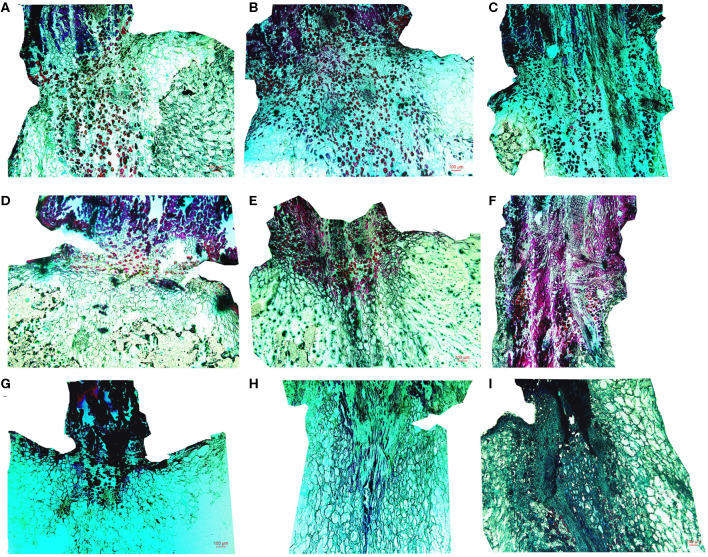
The microstructure of the stalk–berry junction cells of table grapes stored for 0, 3, or 6 days (×50). After storage for 0 day in “Muscat Kyoho” (A), “Kyoho” (B), and “Nanyu” (C); after storage for 3 days in “Muscat Kyoho” (D), “Kyoho” (E), and “Nanyu” (F); after storage for 6 days in “Muscat Kyoho” (G), “Kyoho” (H), and “Nanyu” (I). All images are of transverse sections.